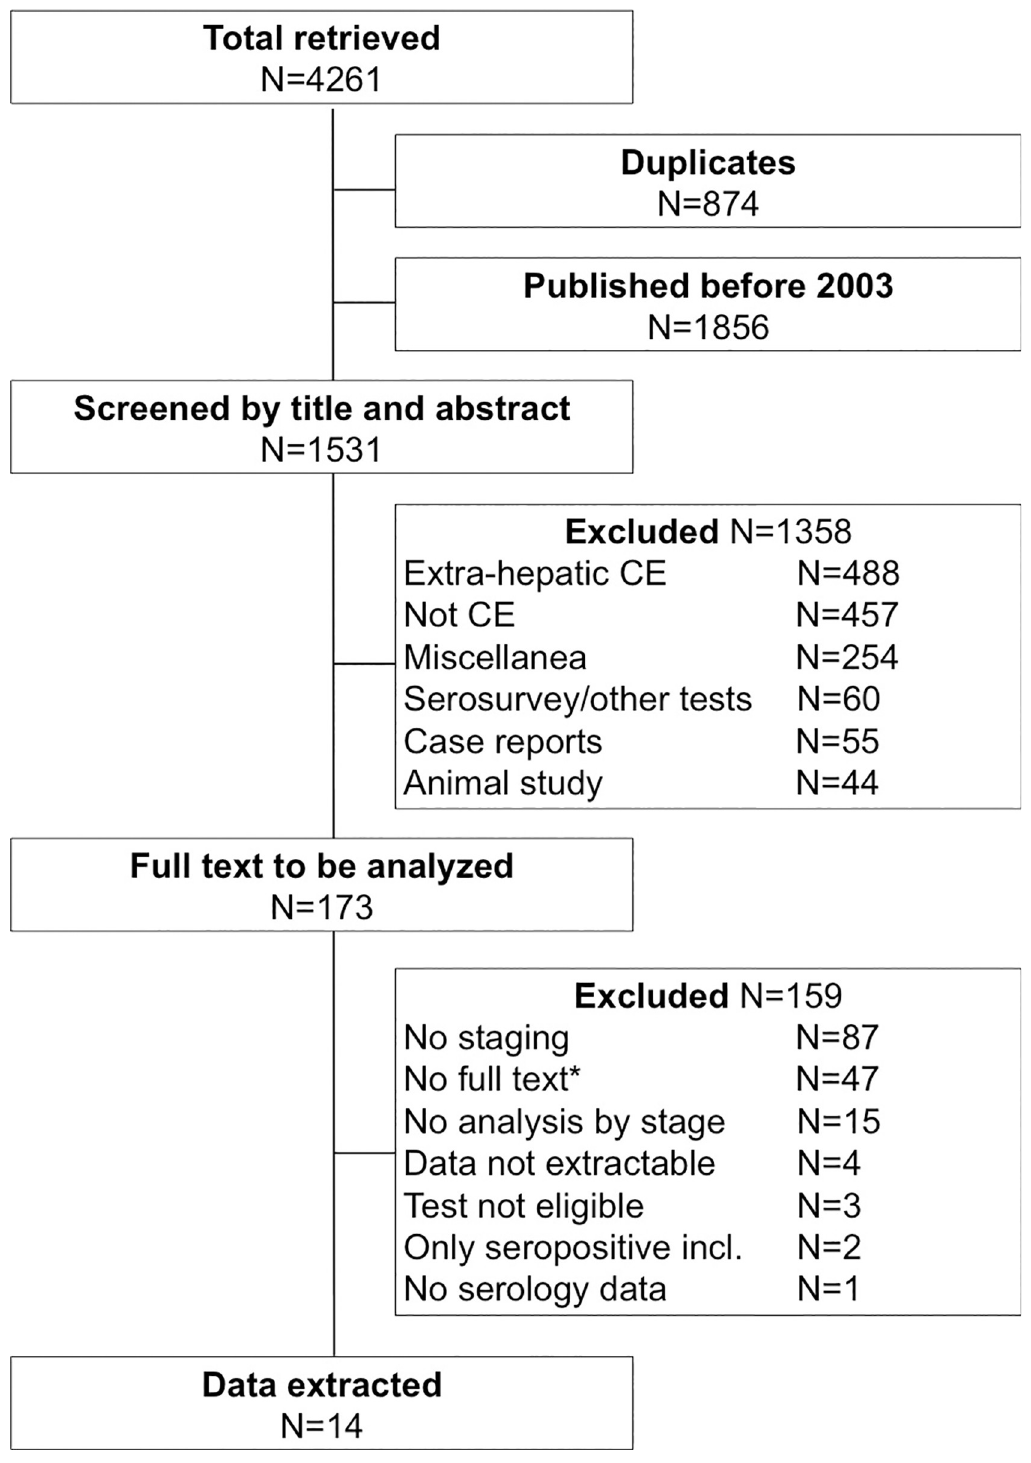
Fig 1. Flow diagram of the literature